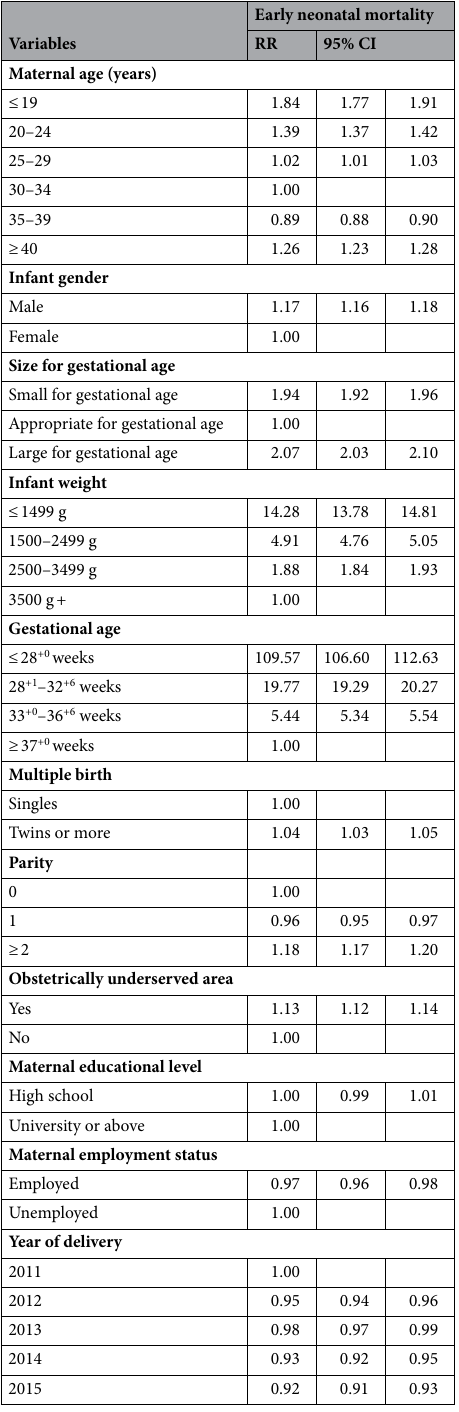
Table 2. Risk ratios (RR) (95% CI) for early neonatal mortality according to